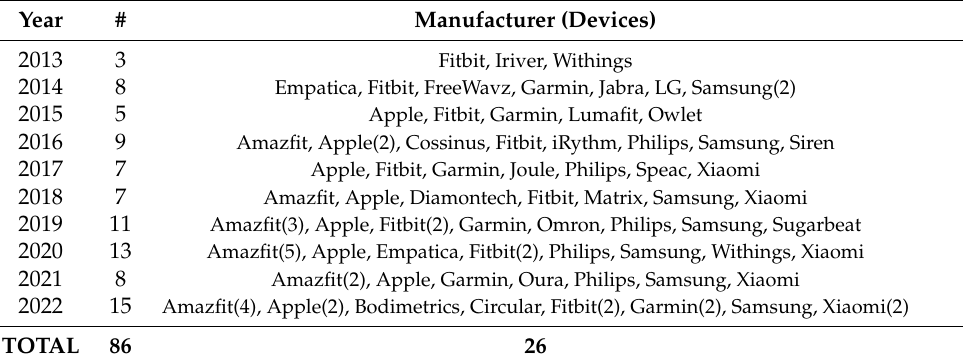
Table 2. Commercialized devices selected for this study, ordered by publication